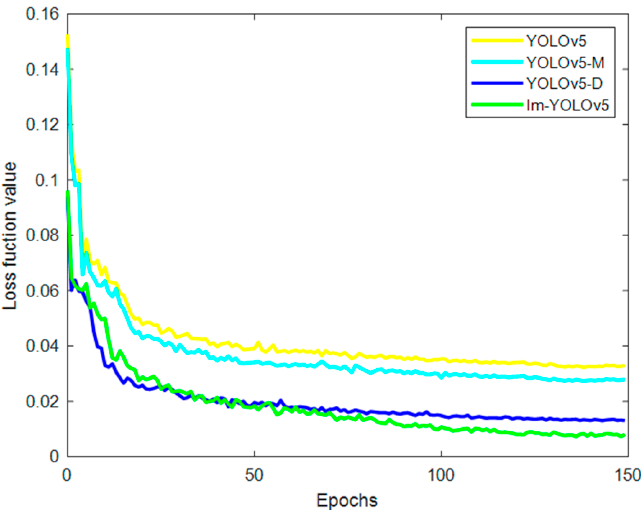
Figure 12. Loss value curve changes with